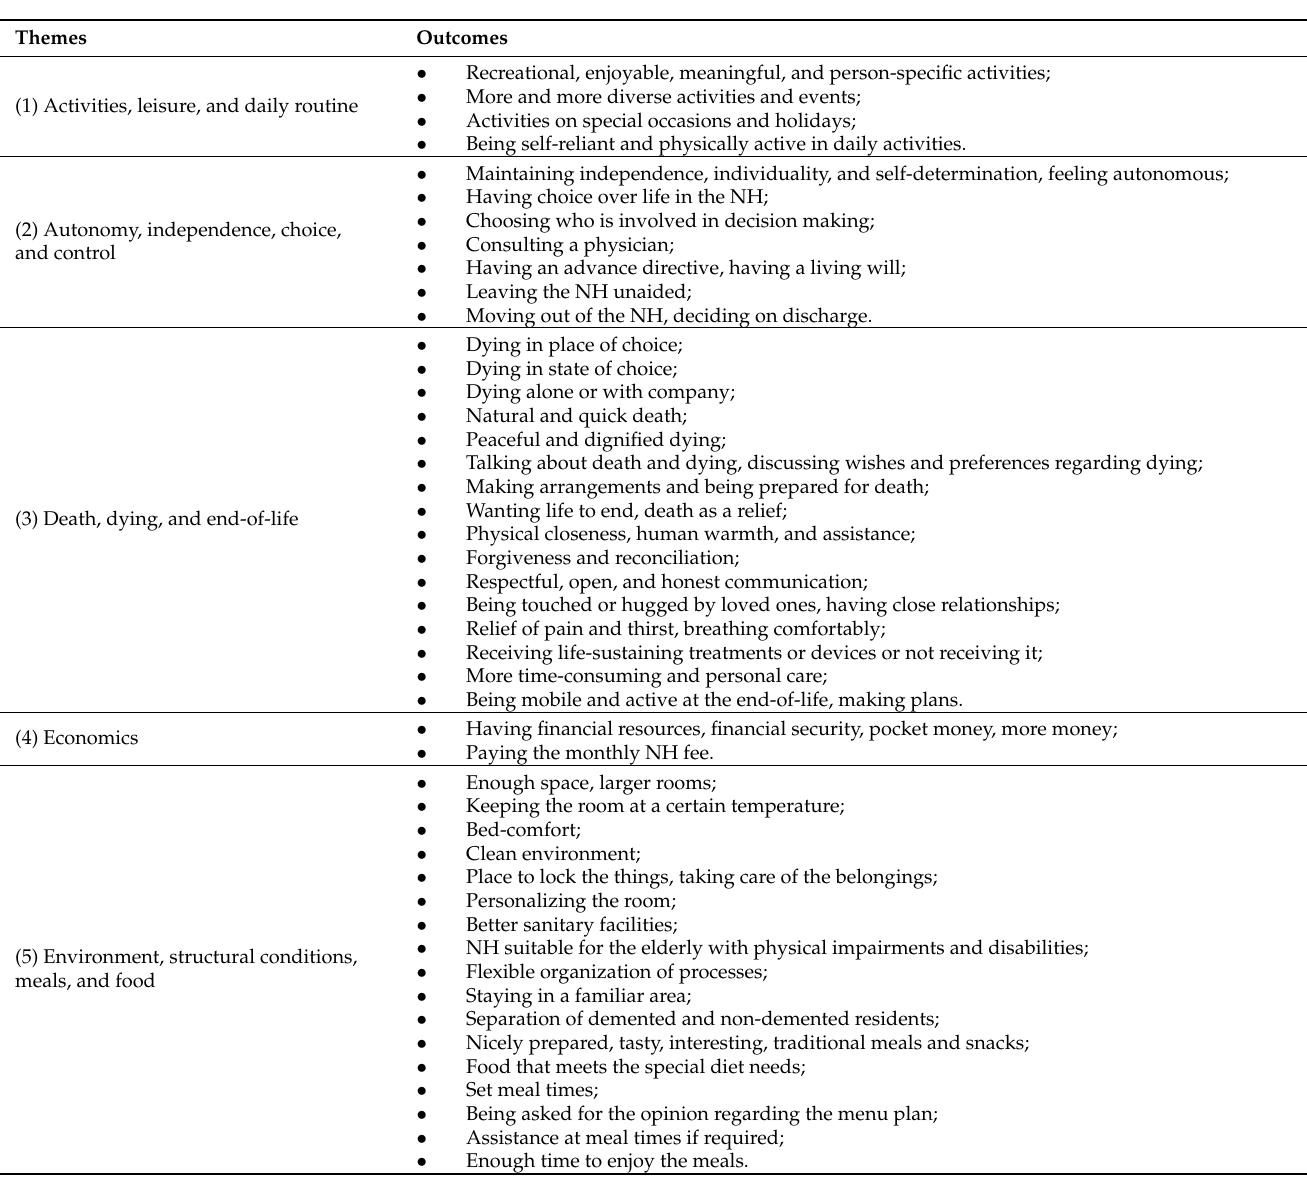
Table 3. Explicit description of the